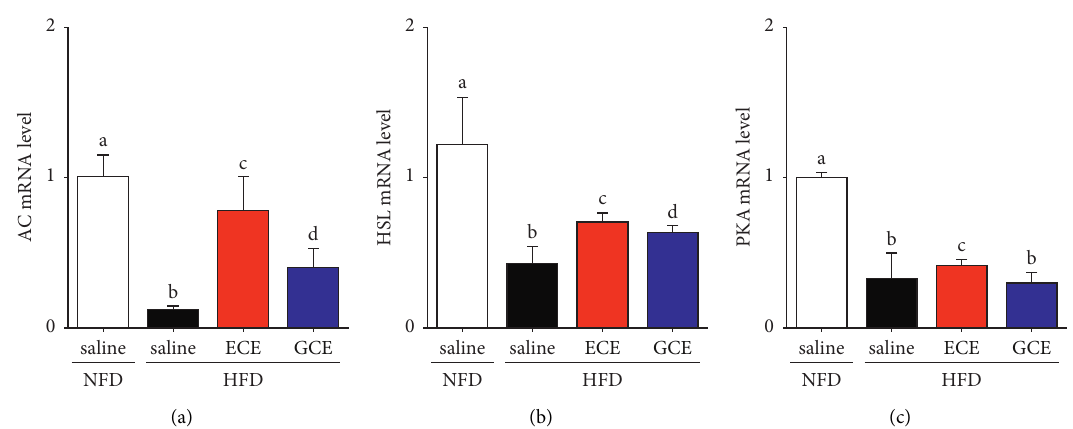
Figure 6: Effects of E . cava extract on adipocyte lipolysis in response to an agonist upregulation in visceral fat of high-fat diet- (HFD-) induced obese mice. To validate adipocyte lipolysis related markers such as (a) AC, (b) HSL, and (c) PKA in visceral fat of standard normal fat diet with 0.9% saline (NFD/saline; open bar), HFD with 0.9% saline (HFD/saline; black bar), HFD with E . cava extract (HFD/ECE; red bar), and HFD with Garcinia cambogia extract (HFD/GCE; blue bar) groups, these mRNA expression levels were assessed by qRT-PCR. All mRNA levels expressed relative level and normalized ß-actin of the NFD/saline group. The same letters represent no significant difference ( p < 0 .